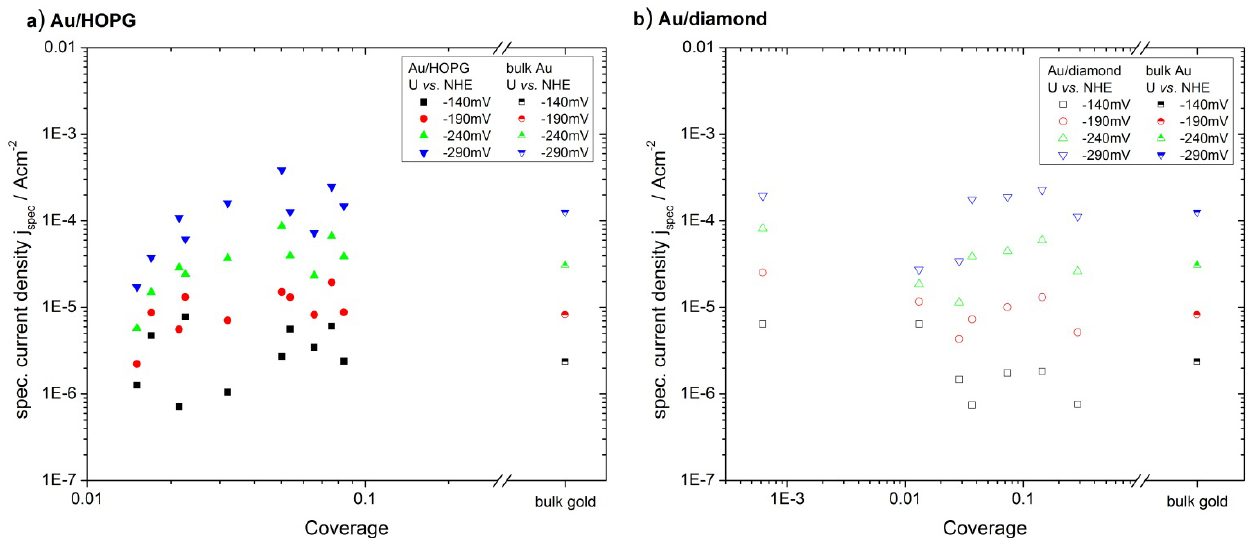
Figure 8. Specific current density for HER for Au/ HOPG ( a ) and Au/diamond ( b ) evaluated from current-potential curves. The specific current density does not show a clear trend for decreasing gold coverage. The data for an extended gold surface was added as a